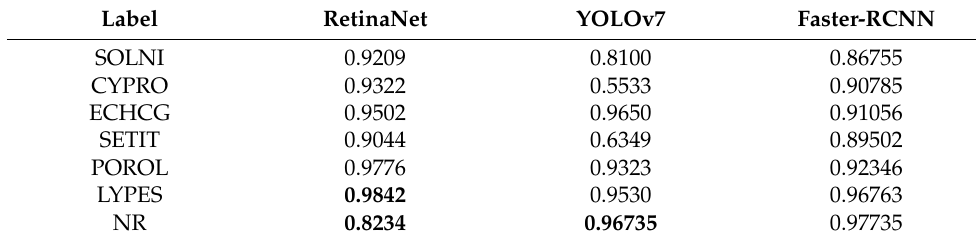
Table 4. Prediction AP values on the validation set per Object Detection Model and species.